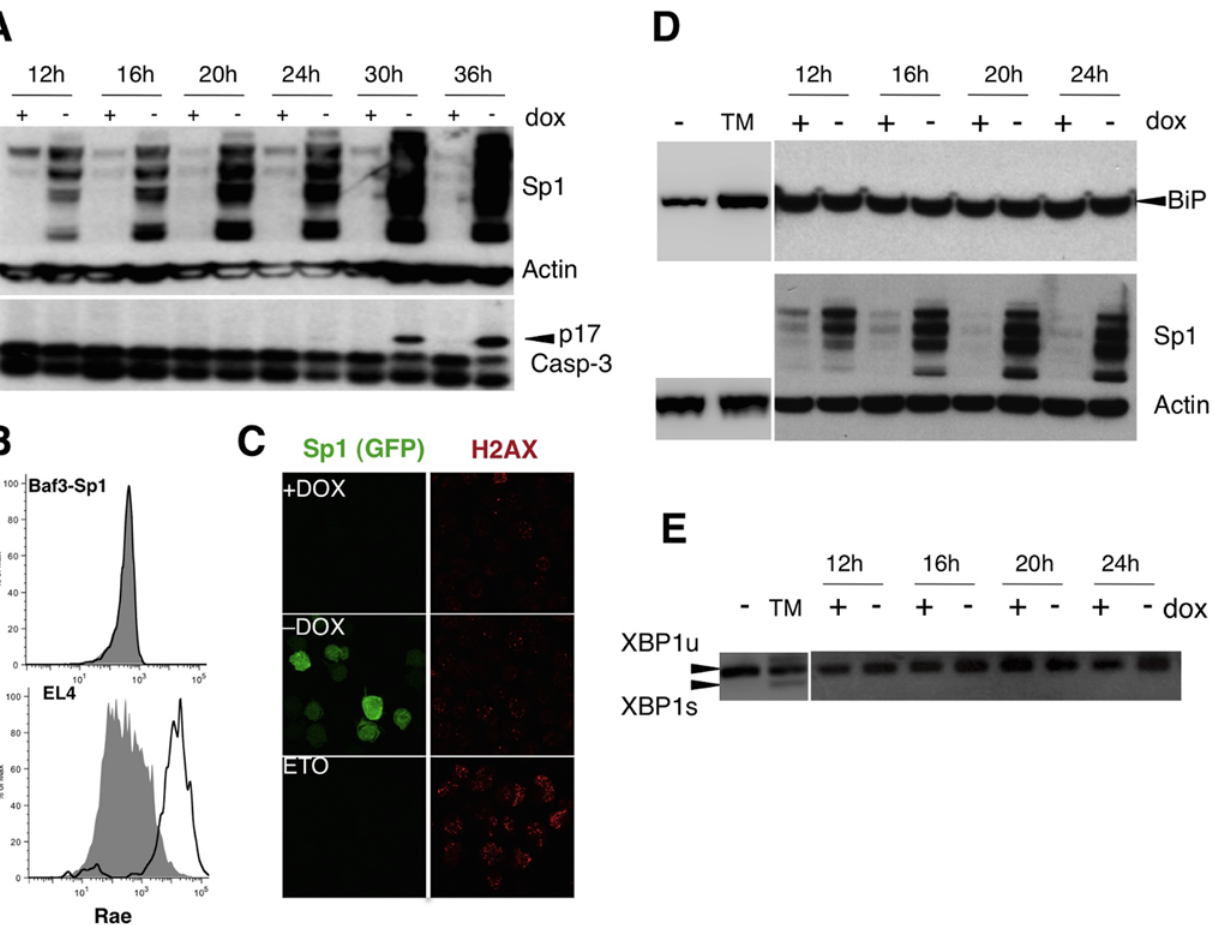
Fig 1. Characterization of the early cellular response upon Sp1 overexpression. BaF3-Sp1 cells were grown in the presence or absence of dox (Tetracycline-off system to induce Sp1 expression). (A) Cell extracts were collected at the indicated time and expression of Sp1, caspase-3 and actin was analyzed by immunoblot. (B) Twenty hours after dox withdrawal, Rae expression was evaluated by flow cytometry (+DOX: shaded histogram,-DOX: plain line). EL4 (shaded histogram) and EL4-Rae (plain line) cells were used as controls. (C) H2AX staining was performed on BaF3-Sp1 cells grown 24 h in the presence (+DOX) or absence (-DOX) of dox. BaF3 cells treated 24 h with etoposide (2 μ g/ml) were used as positive control (ETO). (D) Cell extracts were collected at the indicated times and expression of Sp1, BiP and actin was revealed by immunoblot. BaF3 cells treated 12 h with Tunicamycin (TM) (10 μ g/ml) were used as positive control for BIP expression. (E) RNA extracts were prepared at the indicated times and XBP1 splicing was evaluated by PCR. BaF3 cells treated 12 h with TM (10 μ g/ml) were used as positive control. Data are representative of at least two independent experiments.